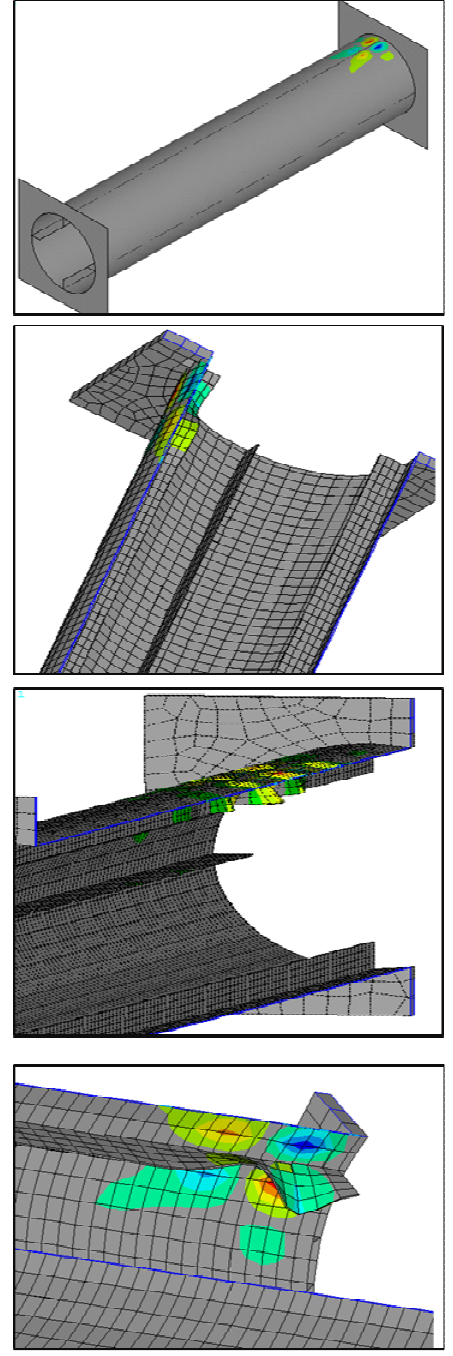
Fig. 6. Loacal buckling of four